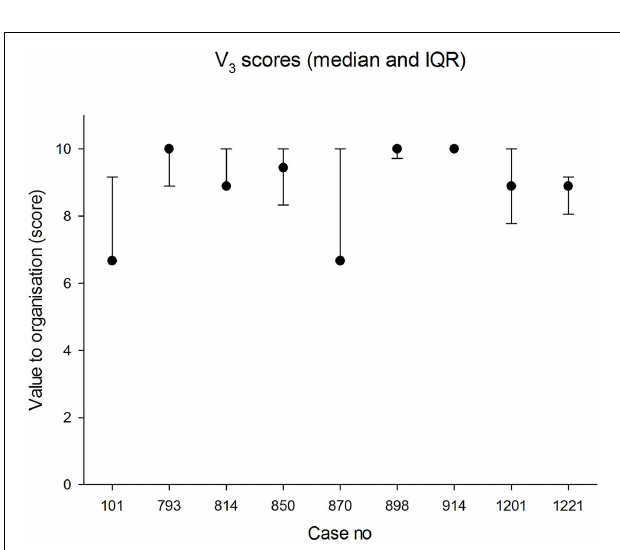
FIGURE 2 | Median scores for value to patient (0 = worst; 10 = best) . The error bars indicate the 25th and 75th percentiles.